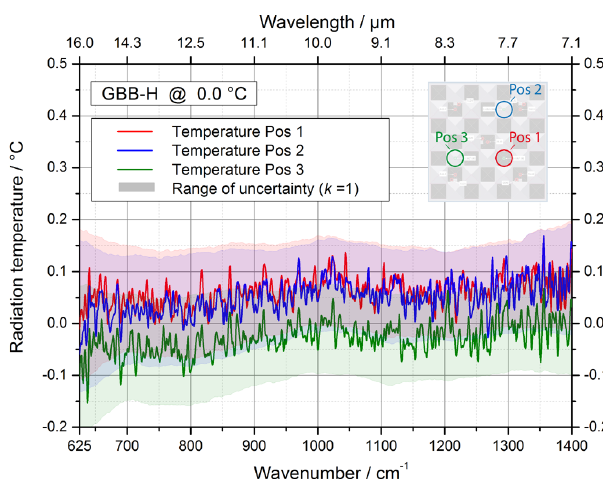
Fig.19. ThespectrallyresolvedradiationtemperatureoftheGBB-CmeasuredwiththevacuumFTSat − 30.3 ◦ Candthreedifferentpositions Fig. 19. The spectrally resolved radiation temperature of the GBB- on the optical surface. The respective ranges of the measurement uncertainty are depicted as shaded areas. The three measurement areas on C measured with the vacuum FTS at − 30.3 ◦ C and three different the optical surface of the GBB-C are shown as circles in the inset. positions on the optical surface. The respective ranges of the mea- Fig. 18. The spectrally resolved radiation temperature of the GBB-H measured with the vacuum FTS at 0 ◦ C and three different positions on surement uncertainty are depicted as shaded areas. The three mea- Fig. 18. The spectrally resolved radiation temperature of the GBB- the optical surface. The respective ranges of the measurement uncertainty are depicted as shaded areas. The three measurement areas on the surement areas on the optical surface of the GBB-C are shown as H measured with the vacuum FTS at 0 ◦ C and three different posi- optical surface of the GBB-H are shown as circles in the inset. circles in the tions on the optical surface. The respective ranges of the measure- ment uncertainty are depicted as shaded areas. The three measure- ment areas on the optical surface of the GBB-H are shown as circles in the inset.